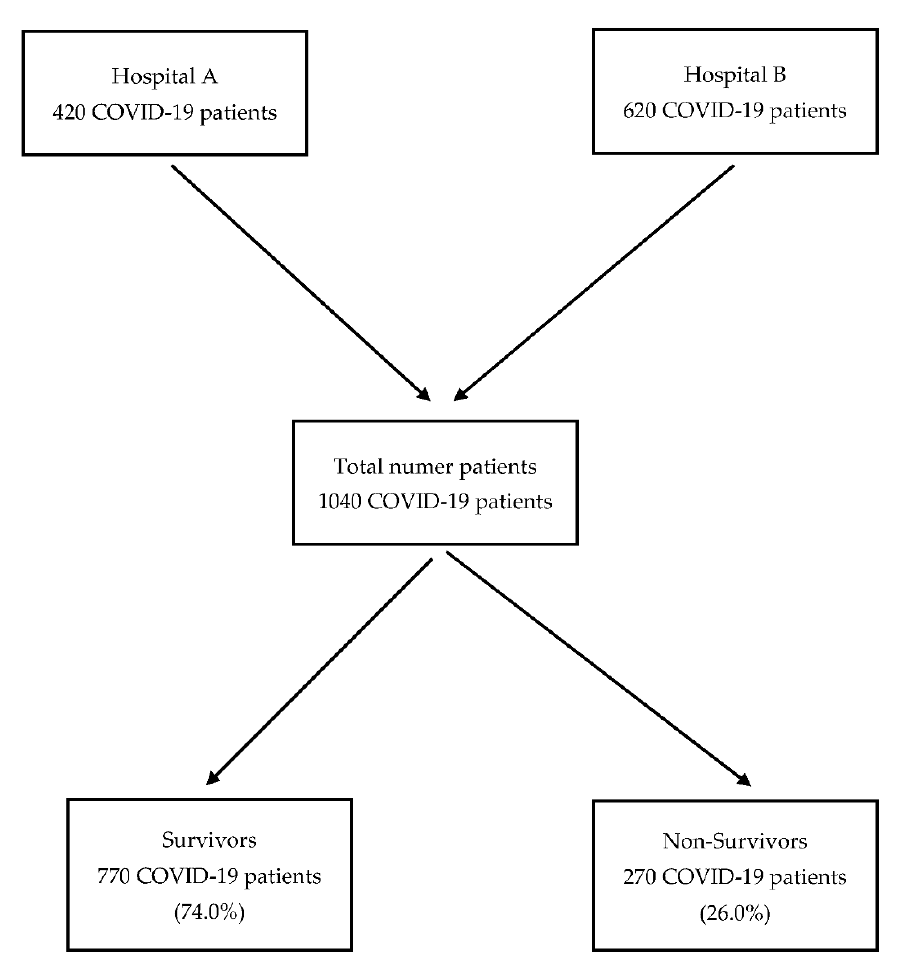
Figure 1. Study flowchart.